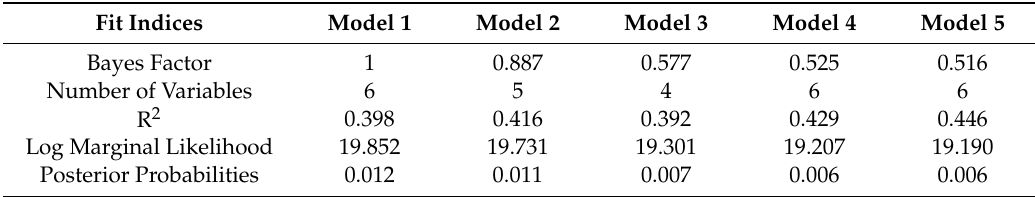
Table 3. Five best models for the blended treatment